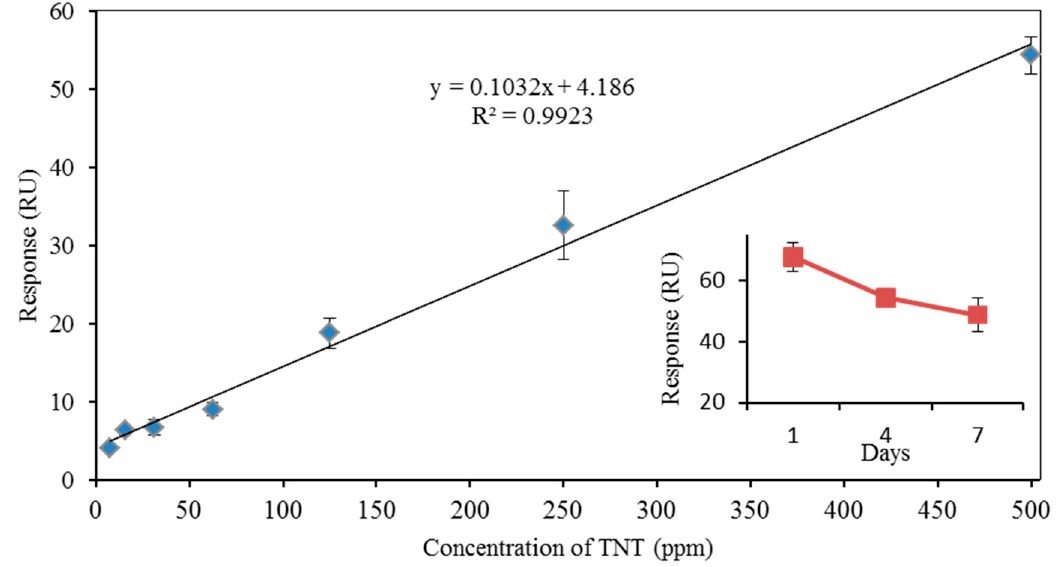
Figure 3. A plot of the response of the APTES-GMBS-based sensor chip immobilized with the TNT binding peptide TNTHCDR3 corresponding to various TNT concentrations (inset: reproducibility of the sensor chip). The error bar indicates the calculated standard deviation ( n = 3).